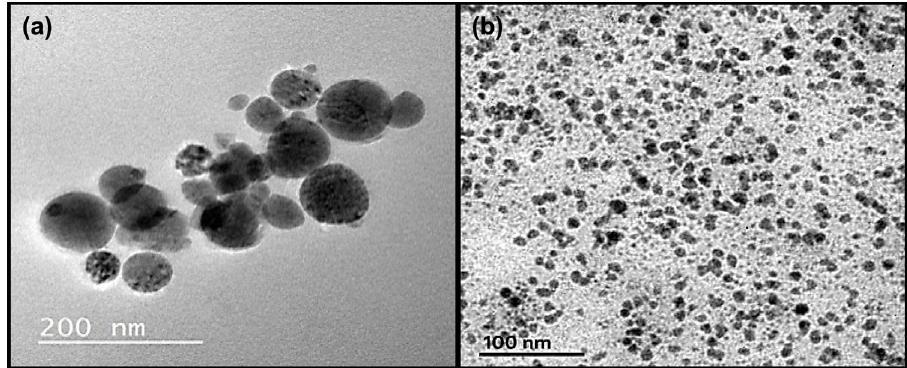
Figure 3: TEM image indicating the size, shape, and morphology of the NC/NSe composite ( a ) and plain NSe ( b )